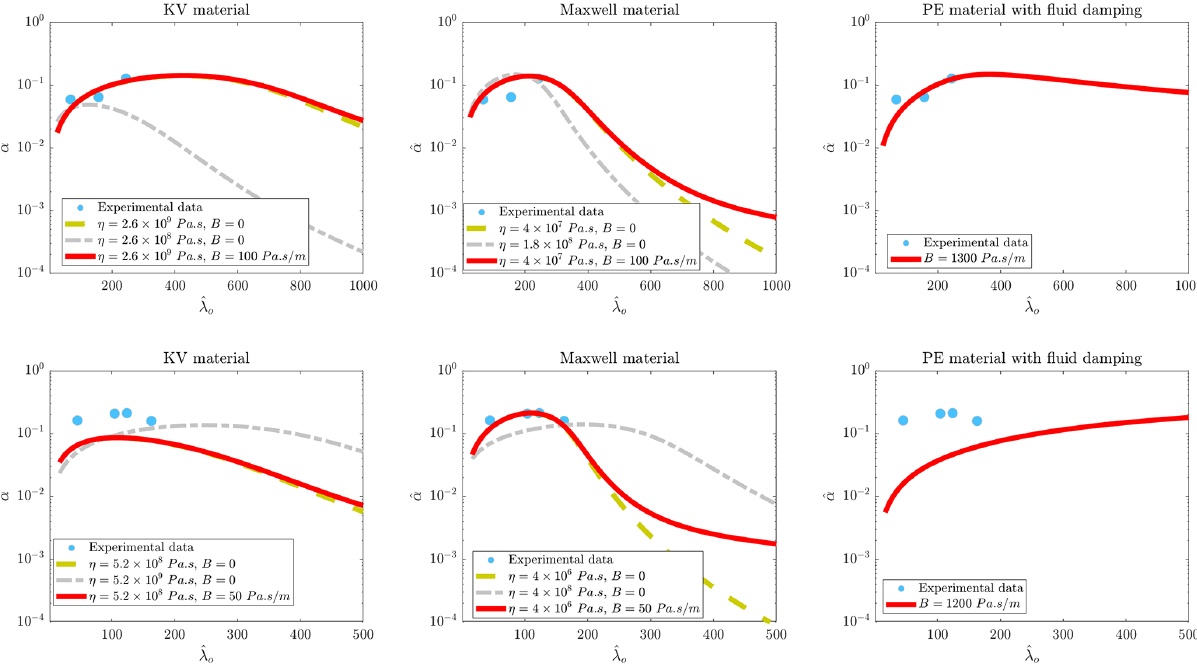
Figure 9. Comparison between ˆ α vs. ˆ λ o curves predicted by models and the data measured by Yiew et al. (2019). Upper and lower rows show the data related to freshwater ice covers with thicknesses of 1 and 1.5cm